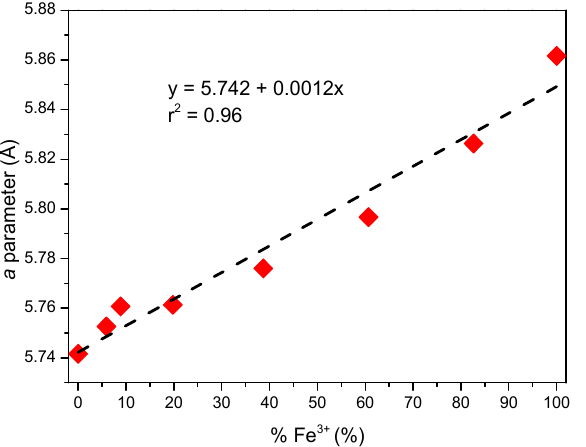
Figure 1. X-ray patterns of samples synthesized: ( A ) shows X-ray patterns of all samples, while ( B , C ) show in detail the variation in the position of the peak due to the (110) plane diffraction with the increasing of the Fe 3+ content in the solids.